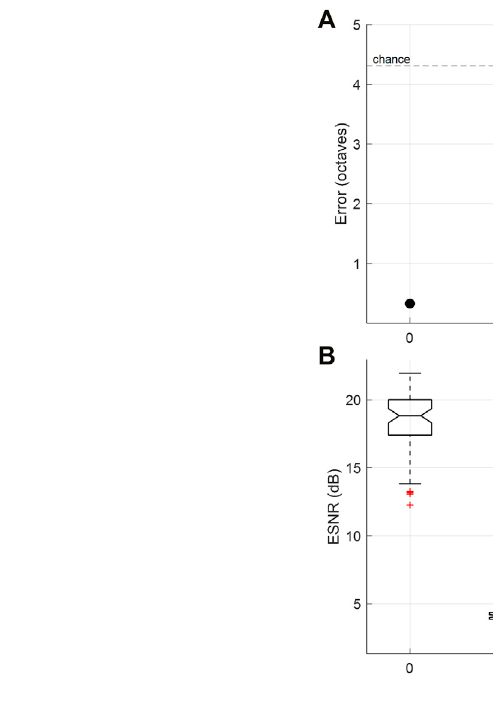
Frontiers in Nanotechnology |